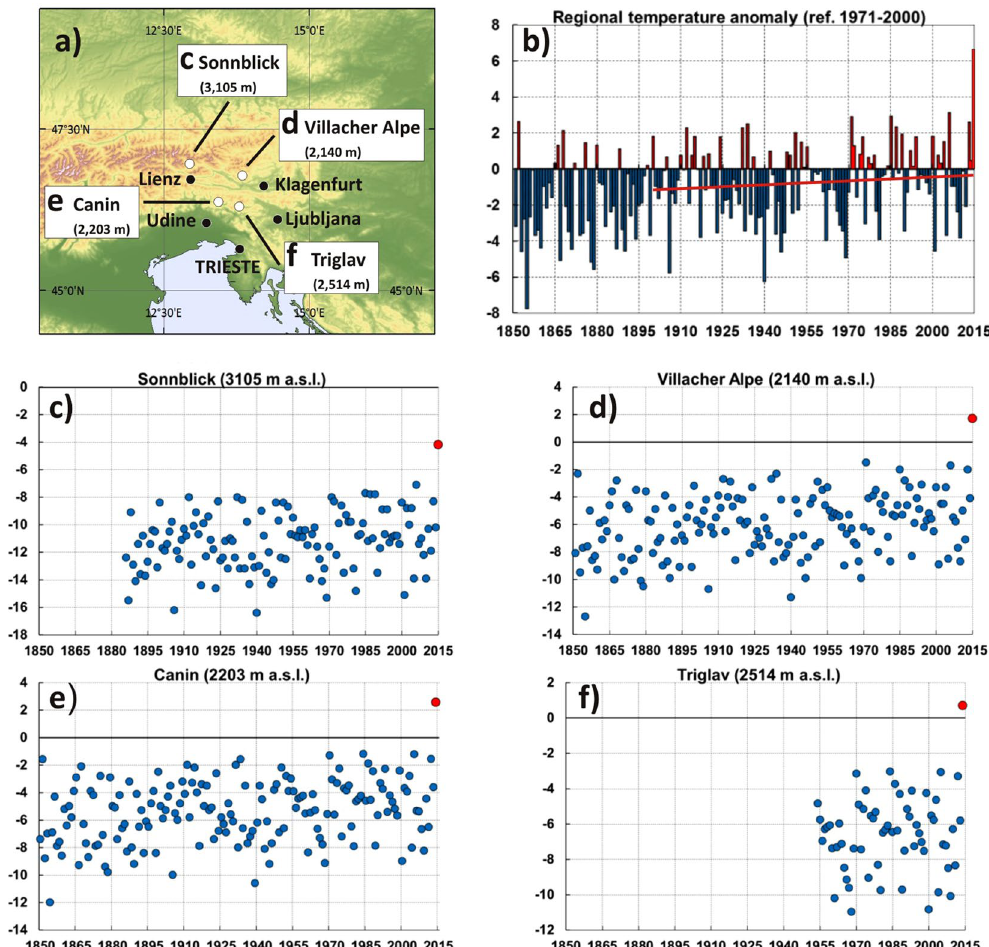
Figure 1. Observed mean December temperature at the four high elevation sites shown in the top left panel (a) ( c , Sonnblick; d , Villacher Alpe; e , Canin; f Triglav). This map has been created with ArcMap version 10.3 and is based on open access digital elevation information from the Shuttle Radar Topography Mission (http://srtm. csi.cgiar.org), further edited by using the CorelDRAW graphic suite, release × 3 (http://www.corel.com). The temperature anomaly (compared to the 1971–2000 mean) averaged over the four sites is shown in the top right panel (b). Units are